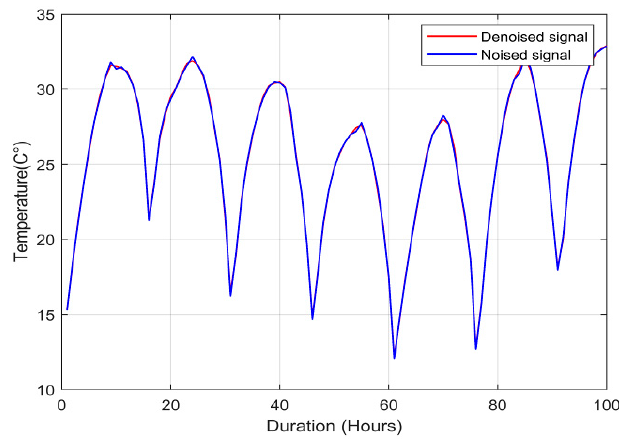
Figure 3. Application of wavelet signal denoising to temperature data.